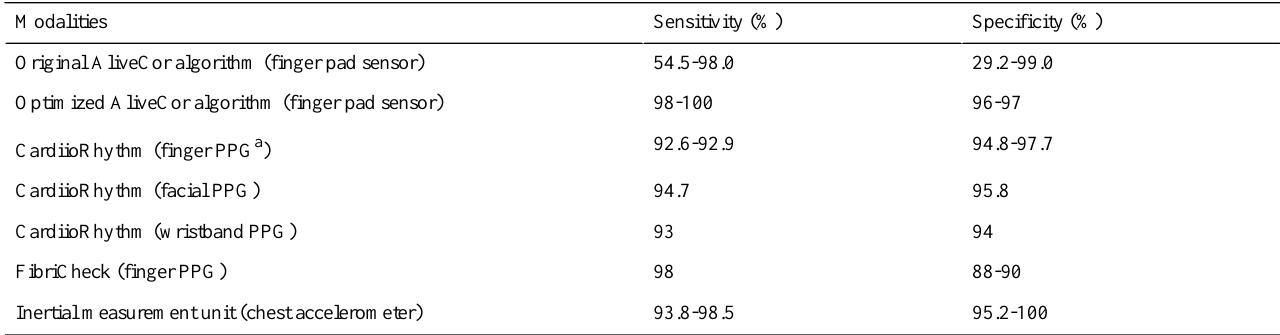
Table 1. Sensitivities and specificities for the 5 main technologies applied in atrial fibrillation detection.